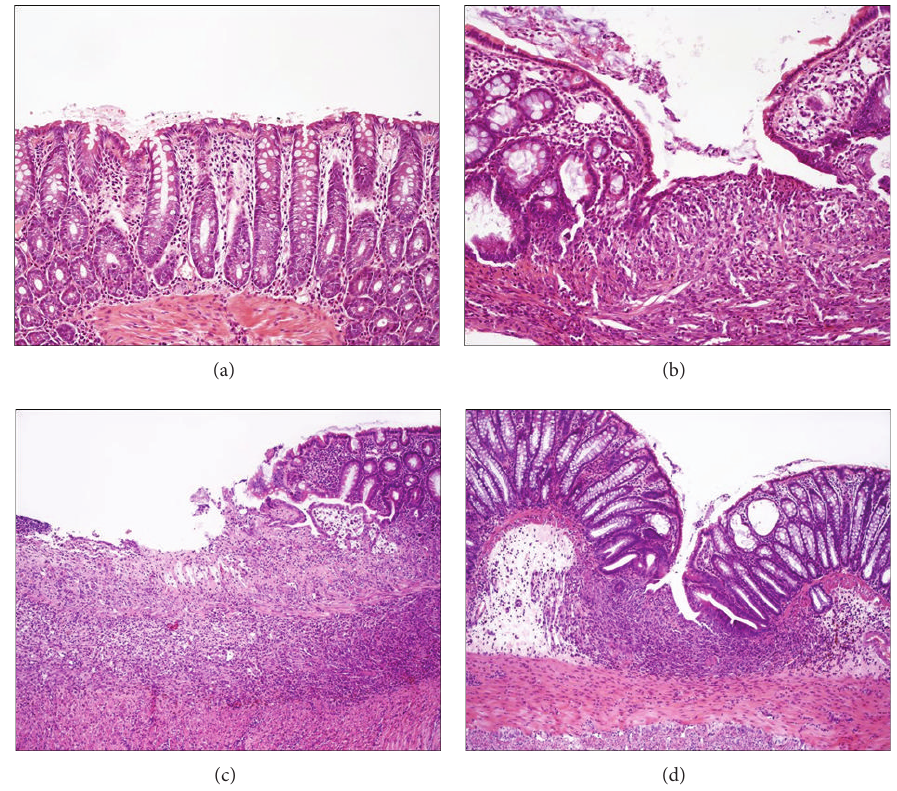
Figure 3: The histological appearance of colonic mucosa of intact rat (a) and the colonic mucosa of rat with TNBS colitis fed normal diet (b) or fed HFD without exercise (c) and HFD with exercise (d) at day 14 after TNBS induction. Note the normal architecture of the colonic crypts in intact rat (a) and the severe damage as manifested by a partial loss of normal architecture and deep ulceration reaching muscularis mucosa (b). This histological damage was potentiated in untrained rat fed HFD showing complete loss of architecture accompanied by severe inflammation (c). In contrast, in trained rat fed HFD, both the area of colonic damage and the inflammatory reaction were reduced and more regeneration around the ulceration was evidently seen